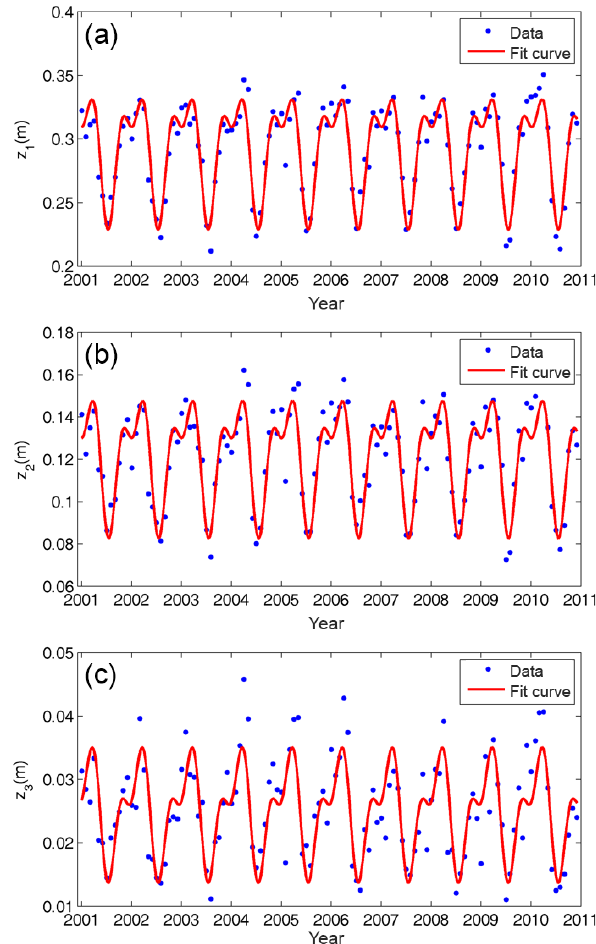
Figure 5. Decadal time series and cycle fitting results of function coefficients z 1 (a) , z 2 (b) , and z 3 (c) at a grid point (0 ◦ N, 0 ◦ E) from 2001 to